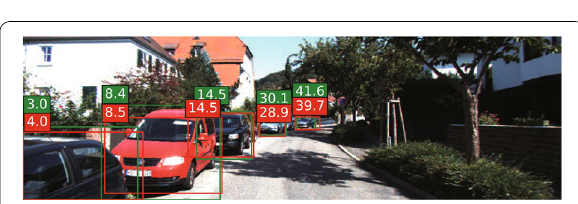
Fig. 14 Examples of estimated distance for multiple cars in KITTI dataset. The ground truth distance and estimated distance are written in green and red boxes respectively. The unit of distance is meter. Only BBs with IoU ≥ 0.7 are shown